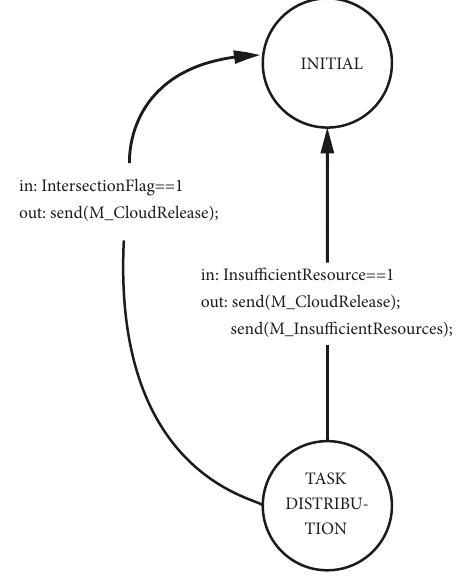
Figure 6: Transition from RESOURCE REQUEST to DISTRIBUTION